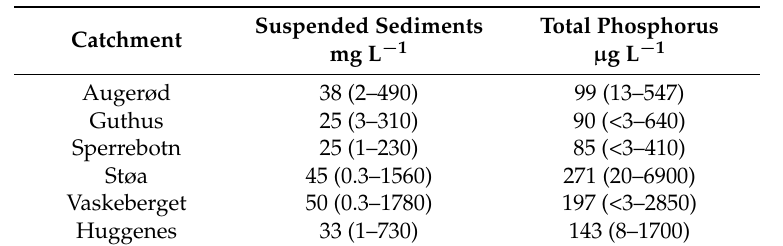
Table 7. Average annual concentrations of suspended sediments (mg L − 1 ) and total phosphorus ( µ g L − 1 ). Range of annual concentrations in brackets.